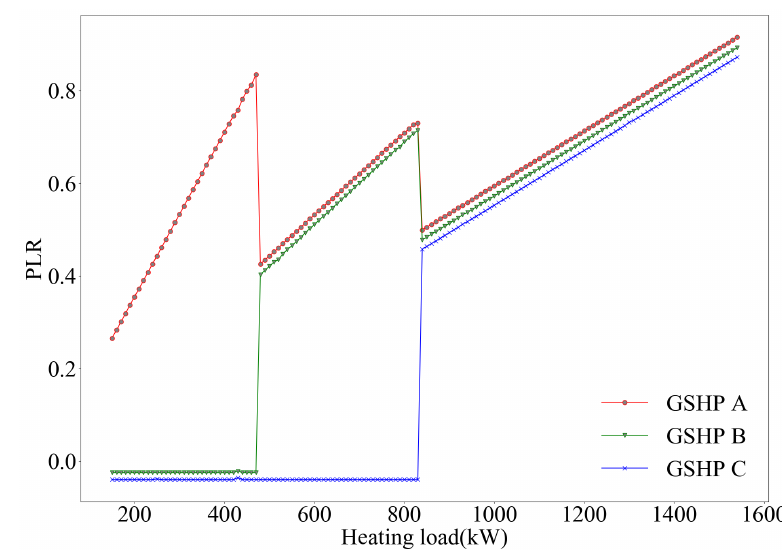
Figure 9. Optimal Part load ratio (PLR) distribution for various heat demand.